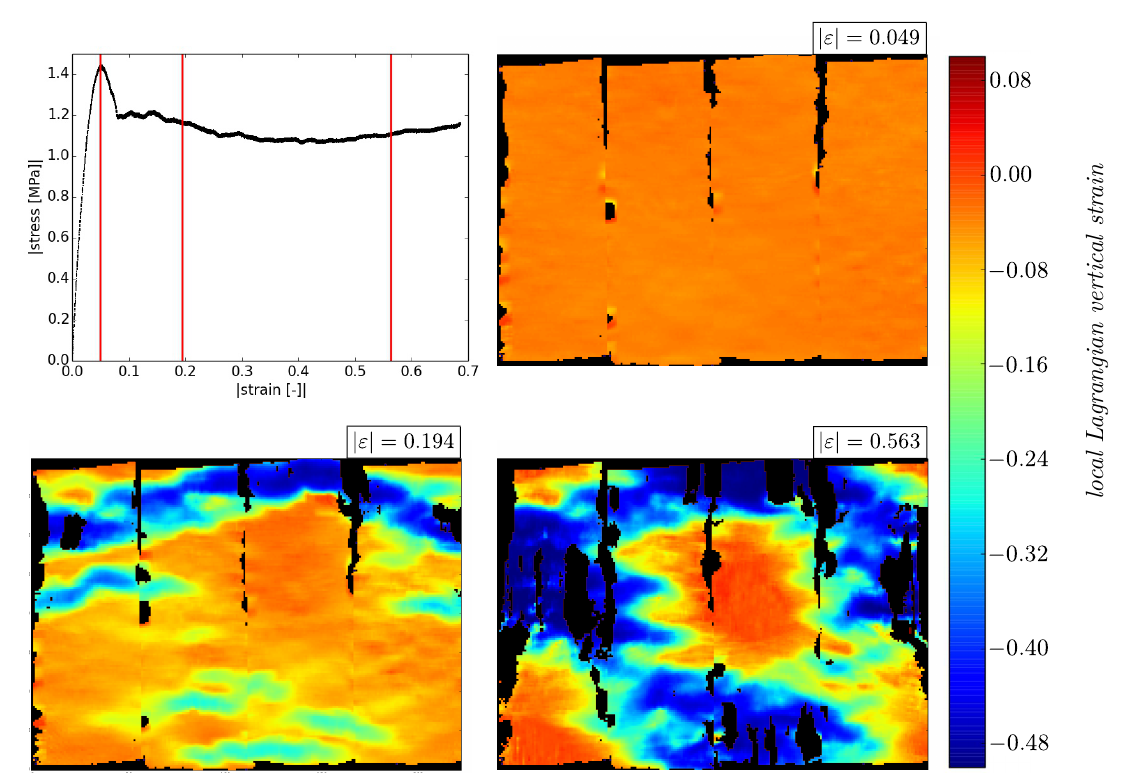
Figure 4. Local Lagrangian vertical strain fields with the corresponding absolute values of the global strain | ε | for a pure compression